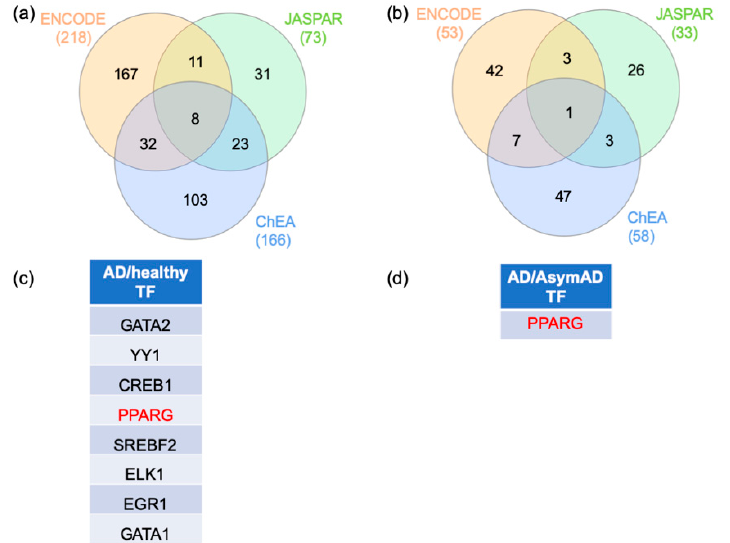
Figure 5. Transcription factors analysis. Transcription factors analysis for the entorhinal cortex from AD/control and AD/AsymAD patients. The gene–transcription factor interaction network was performed with ENCODE, ChEA, and JASPAR. Venn diagram analysis was performed to identify the transcription factors identified by the three methods for AD/healthy ( a , c ) and AD/AsymAD ( b , d ). AD: Alzheimer’s disease. AsymAD: asymptomatic AD. TF: Transcription factor.